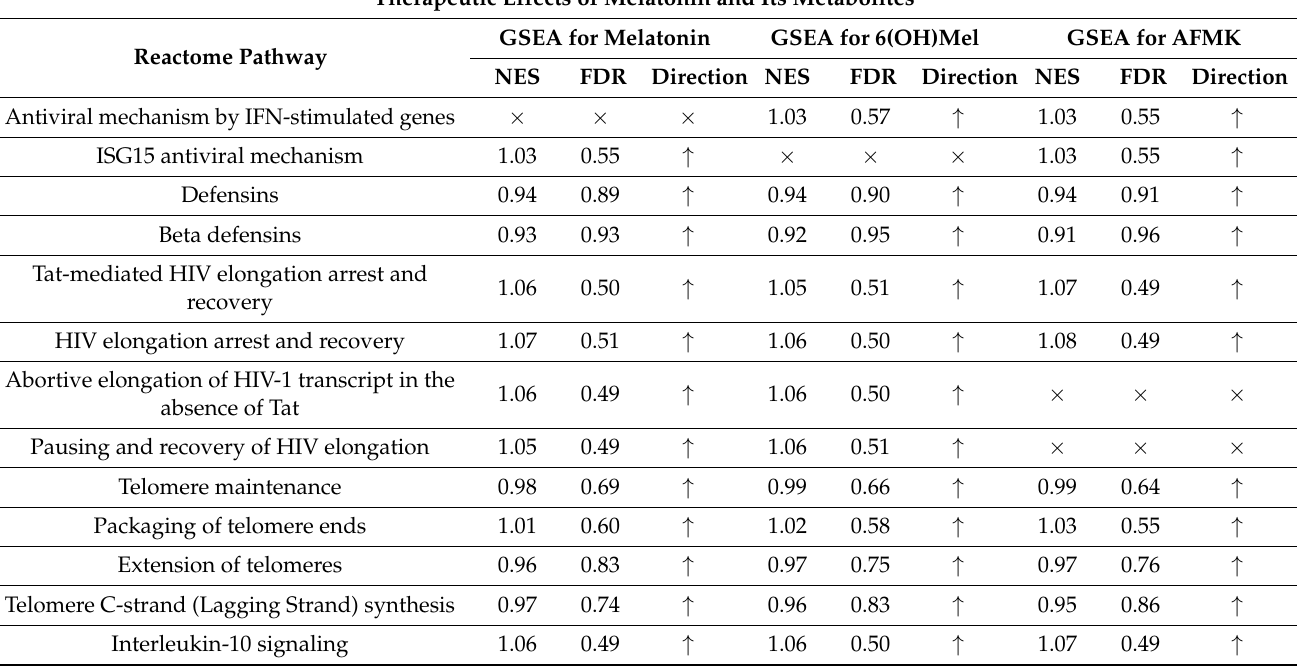
Table 4. Therapeutic implications for melatonin, AFMK and 6(OH)Mel based on GSEA. NES—normalized enriched score; FDR—false discovery rate; ( × )—the effect is